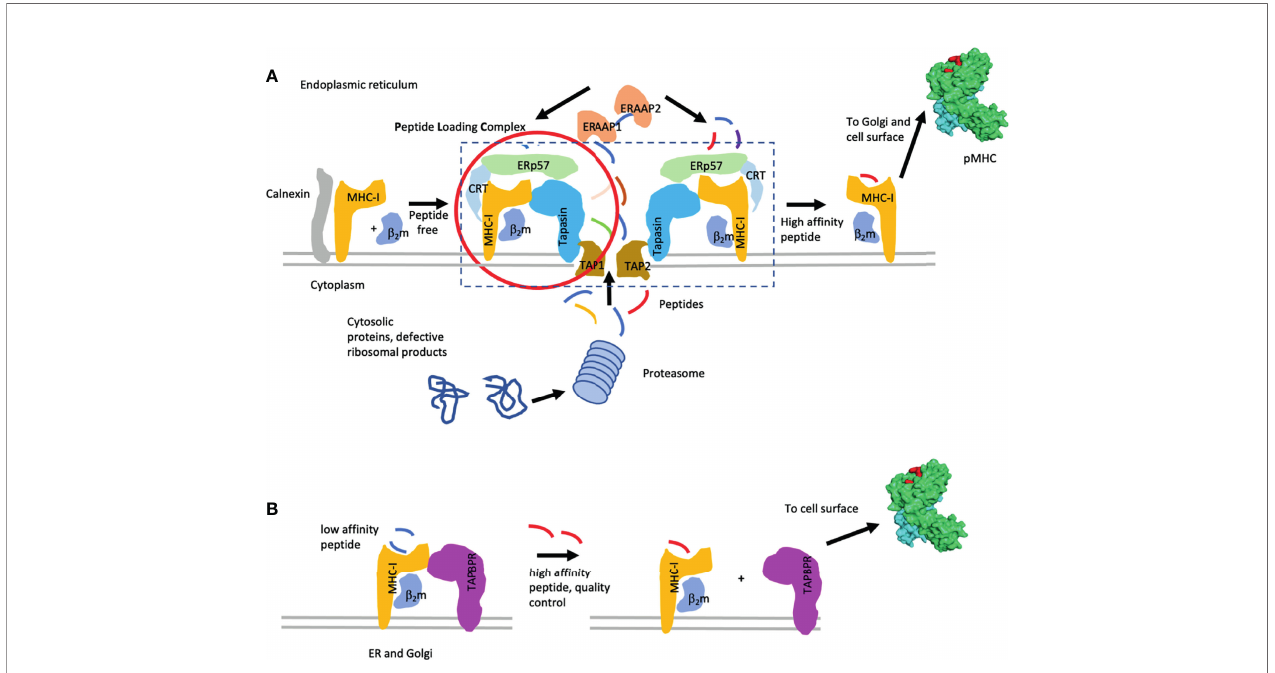
FIGURE 1 | Pathways of MHC-I peptide loading. (A) Classic MHC-I peptide loading pathway is illustrated. Components of the pathway [i.e. the peptide loading complex (PLC)] include the chaperones calnexin, calreticulin (CRT), ERp57, tapasin, and the TAP1/2 peptide transporter. Peptides are indicated. Additional quality control through the UGT pathway is described in the text. (B) Peptide exchange with the chaperone TAPBPR are indicated. Lower af fi nity peptides are replaced by higher af fi nity peptides while the MHC I molecules are stabilized by either tapasin or TAPBPR. When high af fi nity peptide is bound, the MHC I complex dissociates from the chaperone and proceeds to the cell surface. [This fi gure is a modi fi cation of one published elsewhere